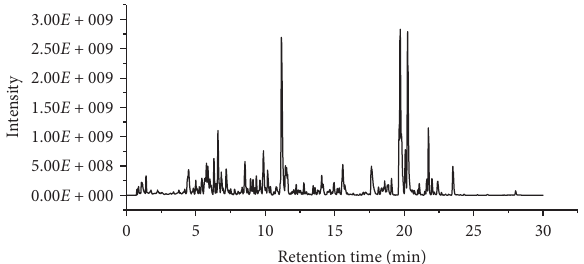
Figure 1: Total ion chromatogram of A. argyi in positive ion mode.